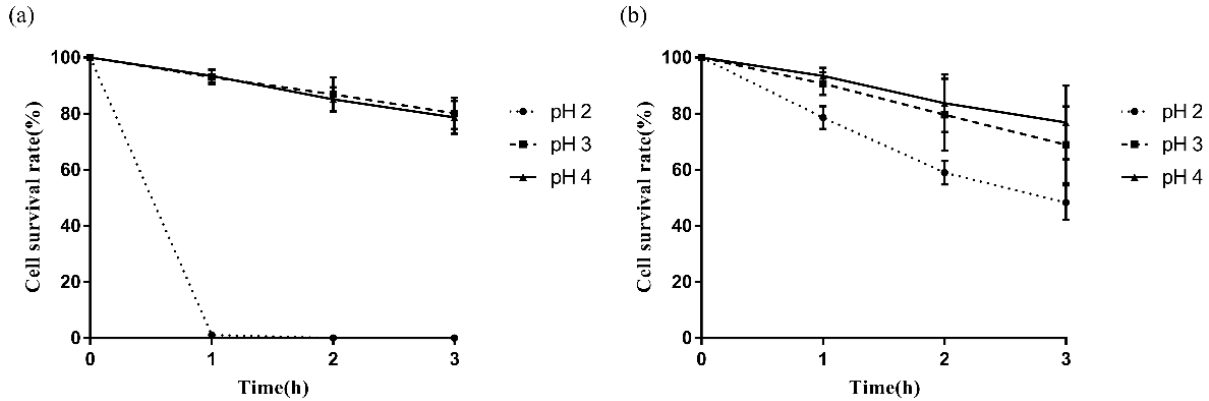
Figure 5. The survival rate of P. pentosaceus 2-5 ( a ) and L. reuteri L-3 ( b ) in different acidic environ- ments after 1 h, 2 h, and 3 h of incubation at 37 °C. The results represent the mean ± SD of three ments after 1 h, 2 h, and 3 h of incubation at 37 ◦ C. The results represent the mean ± SD of three independent experiments. independent